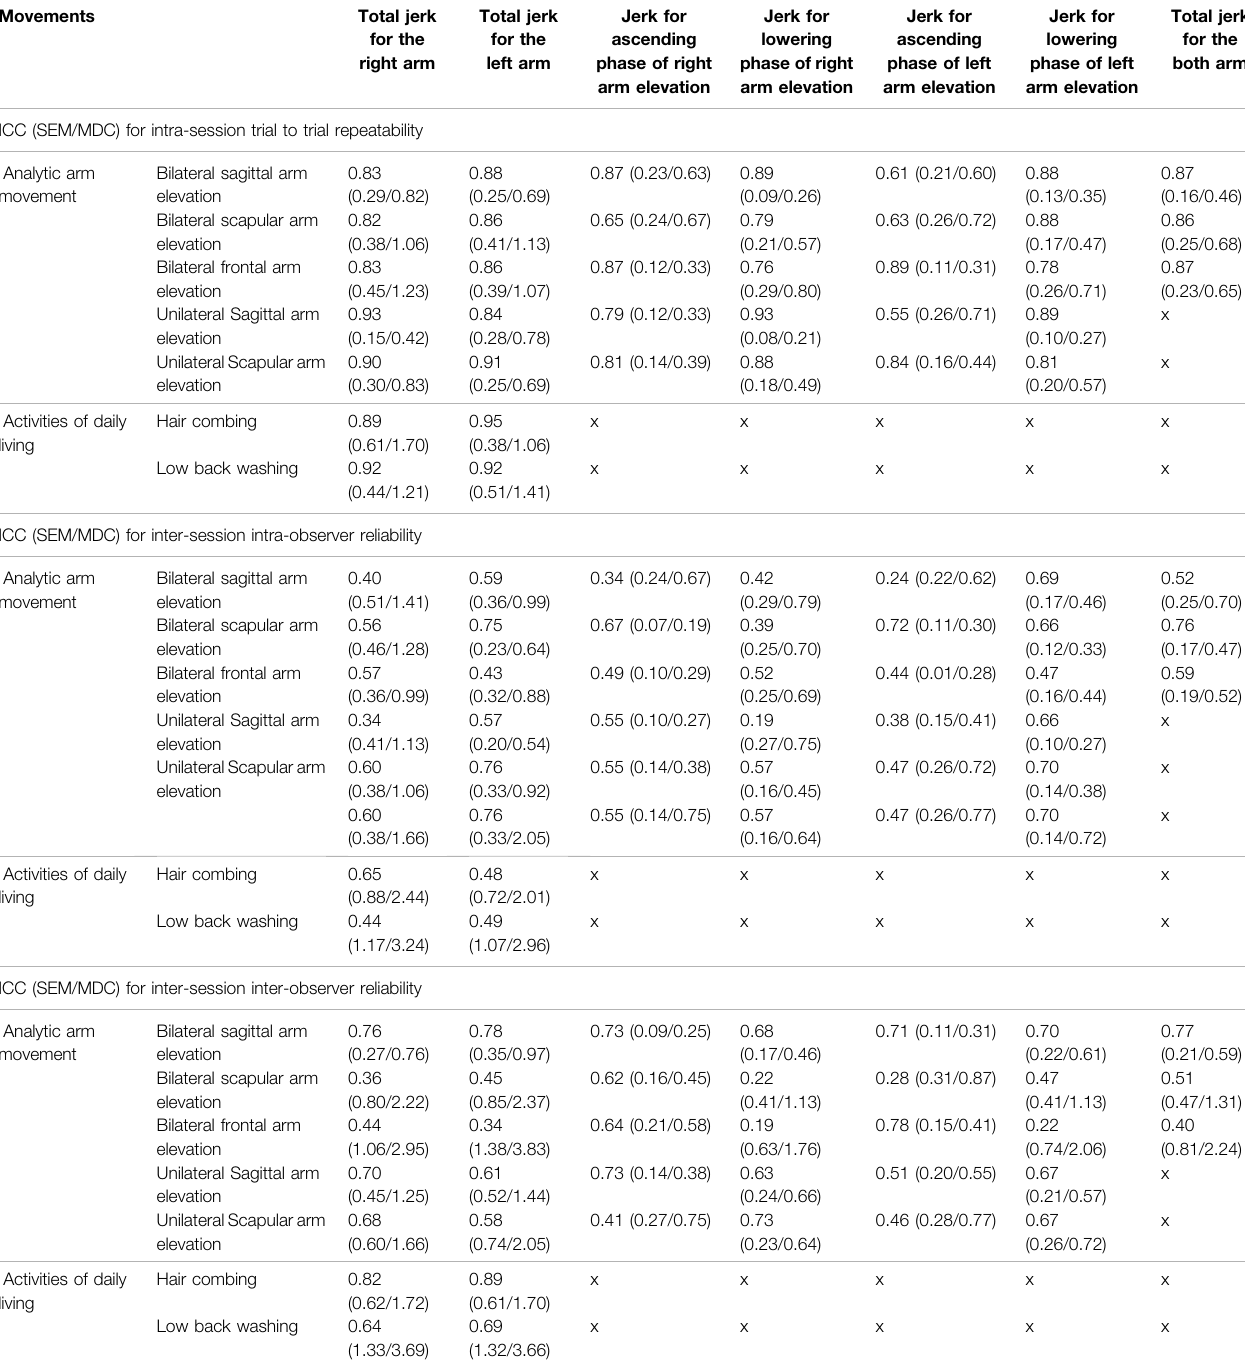
TABLE 2 | Intra-session repeatability, intersession intra and inter observer reliability and agreement of jerk metrics for all arm movements. Movements Total jerk